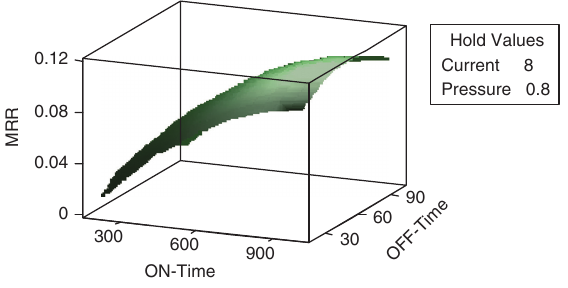
Figure 3 Surface plot of MRR vs. pressure, off time.